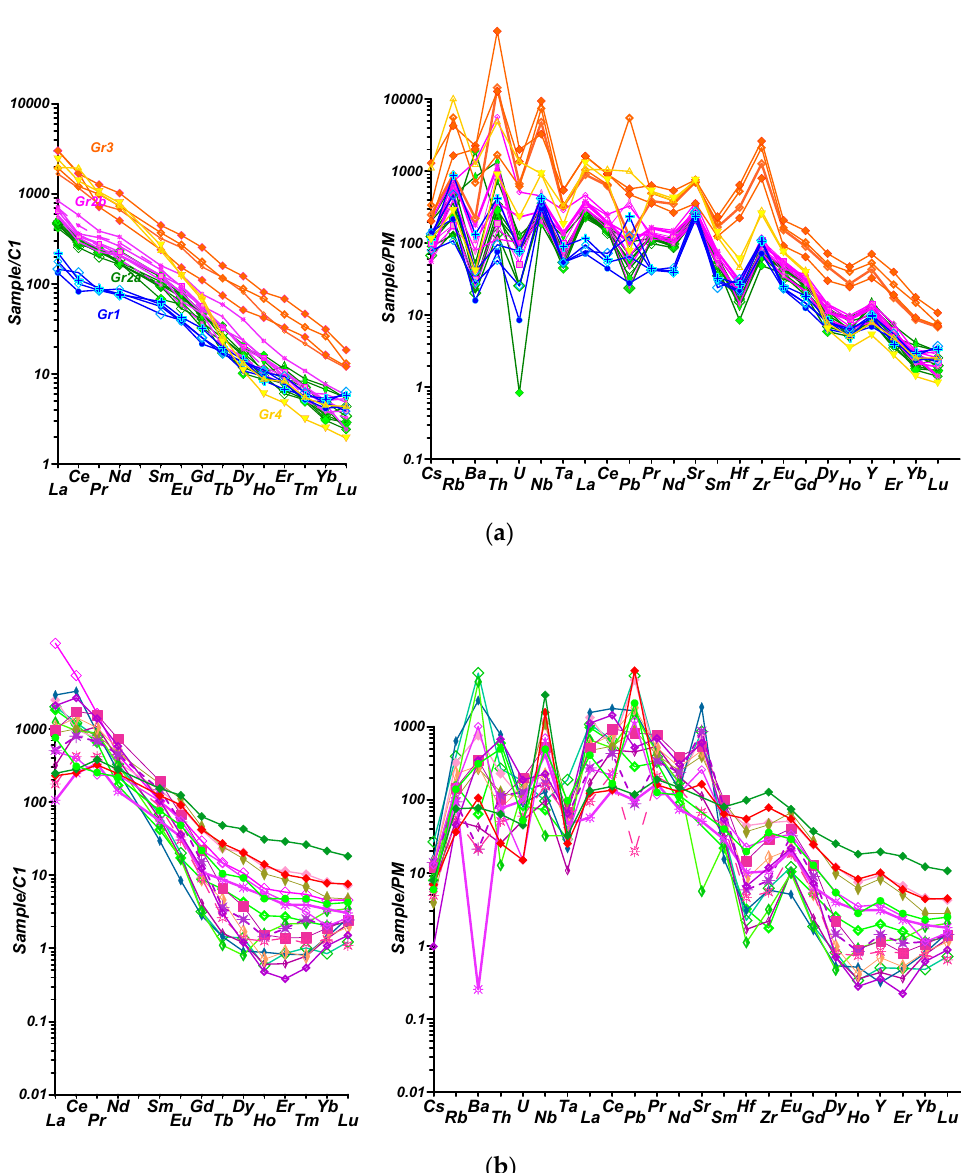
Figure 15. REE and spider-diagrams for the hypothetical melts in equilibrium ( a ) with the Cr- diopsides calculated with KD [98] with the addition of [99,100]; ( b ) with Cr-garnets calculated with KD [101] from mantle xenoliths of Zapolyarnaya pipe. Normalization to chondrite C1 [17] and primitive mantle [32].